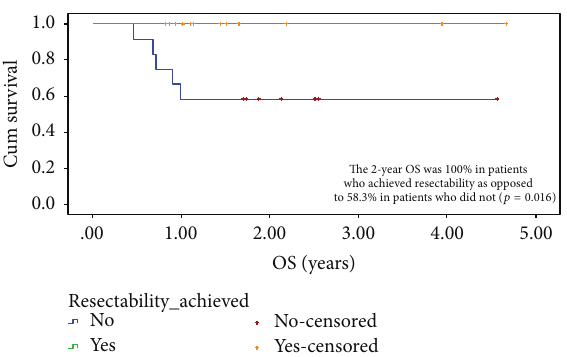
Figure 1: Two-year OS in accordance with achievement of